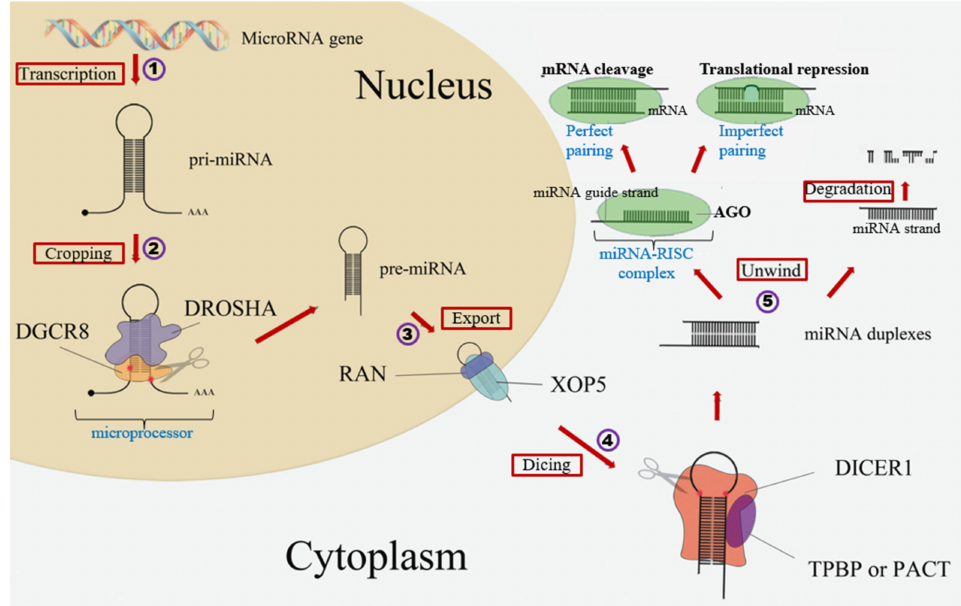
Figure 1. miRNA biogenesis. RNA genes are (1) transcribed to primary miRNA (pri-miRNA) by RNA polymerase enzyme II and then later (2) cropped by the microprocessor (DROSHA-DGCR8) to precursor miRNA (pre-miRNA). (3) Export of these pre-miRNA from the nucleus into the cytoplasm by Exportin-5 (XPO5). (4) Dicing by DICER and then (5) processing into mature miRNA and loaded on the RNA-inducing silencing complex (RISC) to mediate various functions. This figure is adapted with permission from He J. et al, PeerJ, 2016 (https://doi.org/10.7717/peerj.2706). (Accessed on 10 May 2021) DGCR8—DiGeorge syndrome critical region 8, MicroRNA—miRNA, DROSHA—Ribonuclease III, RAN—Ras-related nuclear protein, XOP5—Exportin 5, DICER1—Riboendonuclease, TPBP—Transactivation response RNA binding protein, PACT—Protein activator, AGO—Argonaute protein, mRNA—messenger